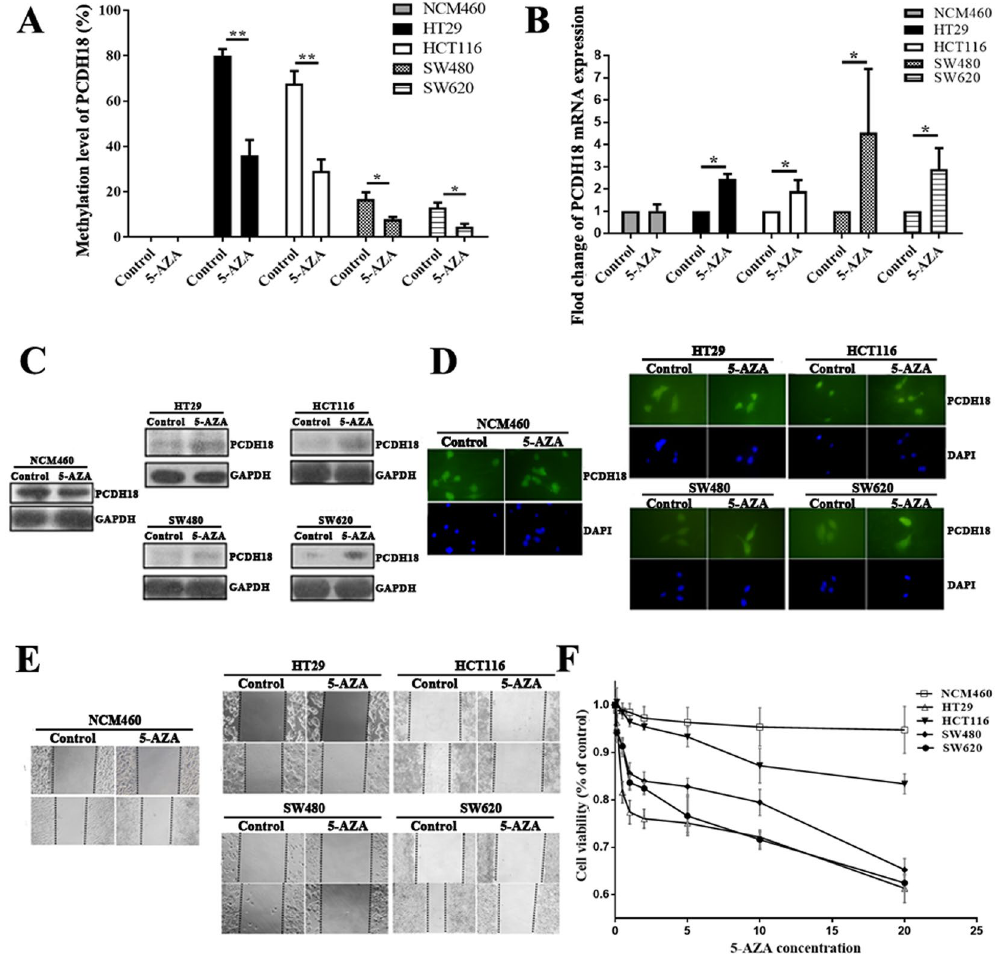
Figure 3. Demethylating agent 5-aza-2 ′ -deoxycytidine (5-AZA) treatment induced PCDH18 expression and inhibited migration and growth in CRC cell lines. ( A ) PCDH18 methylation status after 5 μ m 5-AZA treatment in CRC cell lines (HT29, HCT116, SW480 and SW620) and normal colorectal NCM460 cells are measured by MSP. QPCR ( B ), Western blot ( C ) and Immunofluorescence staining ( D ) were used to examine mRNA and protein expression levels of PCDH18 after 5 μ m 5-AZA treatment in CRC cell lines and NCM460 cells. ( E ) CRC cell lines treated with 5 μ m 5-AZA were examined the ability of cell migration compared with NCM460 cells by Wound healing assays. ( F ) Growth curve of CRC cell lines and NCM460 cells treated with various concentrations of 5-AZA. A negative control treated with PBS (without 5-AZA) were included in each assay. Results were shown with means ± SD. * p < 0.05, ** p <